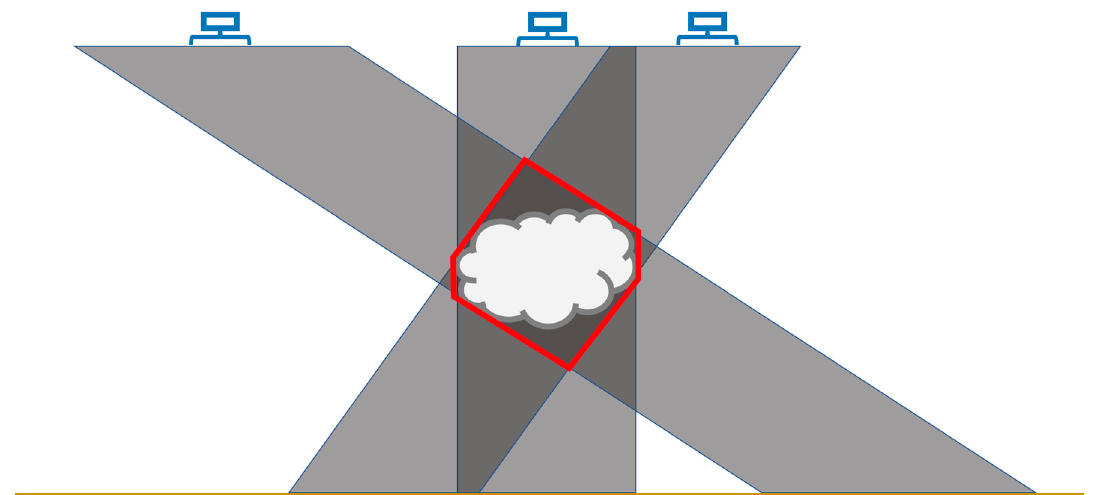
Figure 1. The blue objects at the top represent the satellite sensor retrieving images at three different view angles. The gray areas represent the potential locations of the cloud in the reconstruction domain at each view angle. The brown line at the bottom represents the surface on which the retrieved data are geo-registered. The red lines encircle the space intersected by the three views and hence determine the maximum possible space occupied by the cloud.